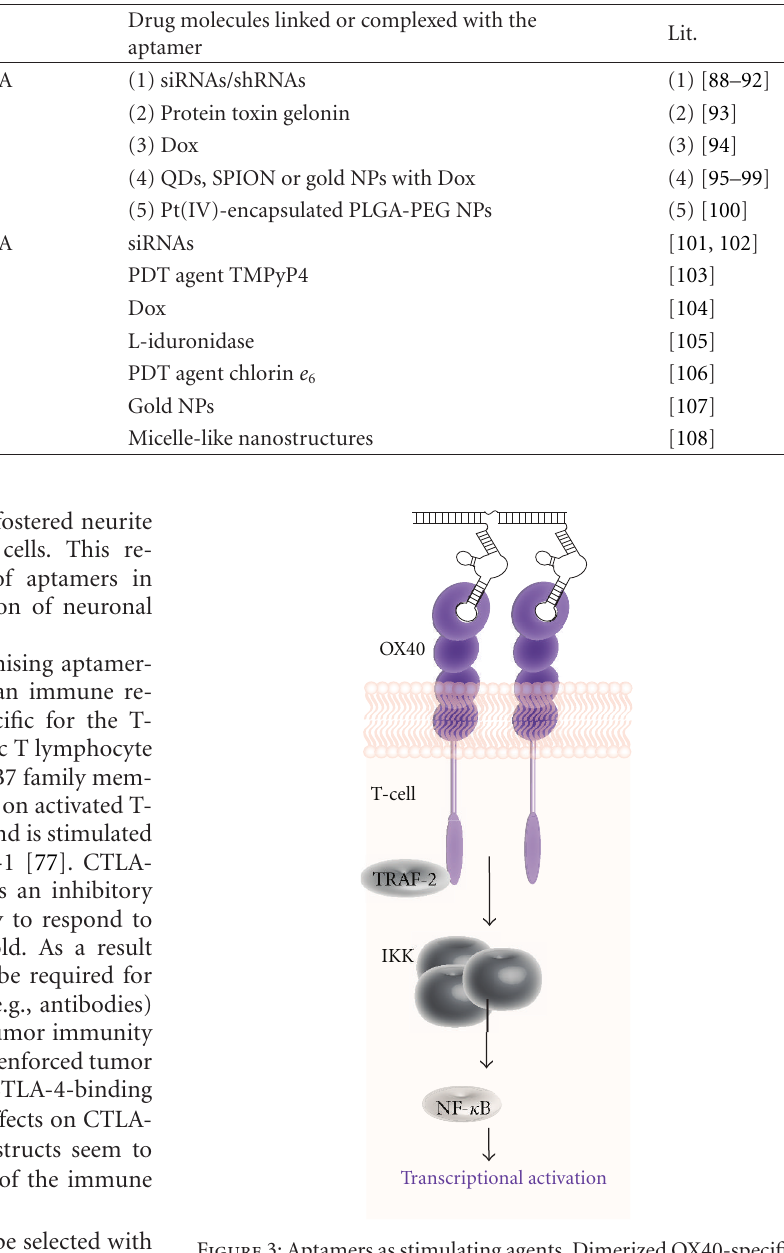
Figure 3: Aptamers as stimulating agents. Dimerized OX40-specific RNA aptamers show activating e ff ects on the OX40 receptor in vitro and in vivo . The OX40 receptor on the surface of activated T cells undergoes receptor oligomerization and provides a costimulatory signal for T cell activation. Downstream factors (e.g., TRAF-2, IKK and NF- κ B) of the signaling cascade are activated leading to an enhanced proliferation of T cells and an increased anti-tumor im- mune